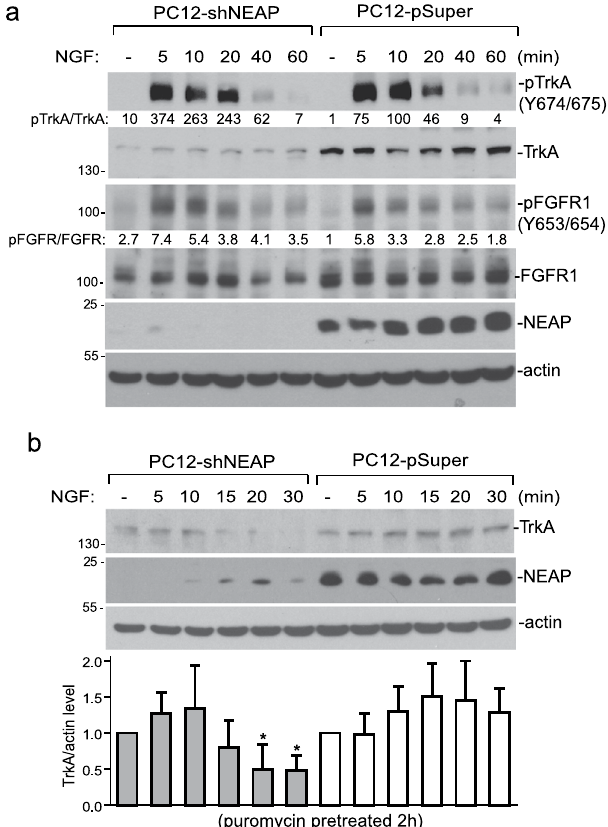
Figure 3. Suppression of NEAP expression increases NGF-induced TrkA and FGFR1 phosphorylation. PC12- pSuper and PC12-shNEAP cells were treated with NGF (50 ng/ml) and the cells were collected at the indicated time points. ( a ) Levels of TrkA, pTrkA, FGFR1 and pFGFR1, and NEAP were examined by immune-blotting assays using specific antibodies as indicated. The pTrkA/TrkA and pFGFR1/FGFR1 ratios in the untreated PC12-pSuper cells were designed as 1. The results from two independent experiments were presented in Supplementary Materials. ( b ) The cells were pre-treated with puromycin (5 μ g/ml) for 2 h and then stimulated with or without NGF (50 ng/ml) for the indicated time periods. The levels of TrkA, NEAP, and β -actin were examined by immune-blotting assays. The ratios of TrkA/actin were determined for each sample and its values in untreated PC12-pSuper and shNEAP cells were designed as 1. The results (mean ± standard deviation) from three immuno blots were analyzed by the Student’s t test. The time points with significantly lower TrkA expression ( p < 0.05) in comparison with the untreated control were indicated with